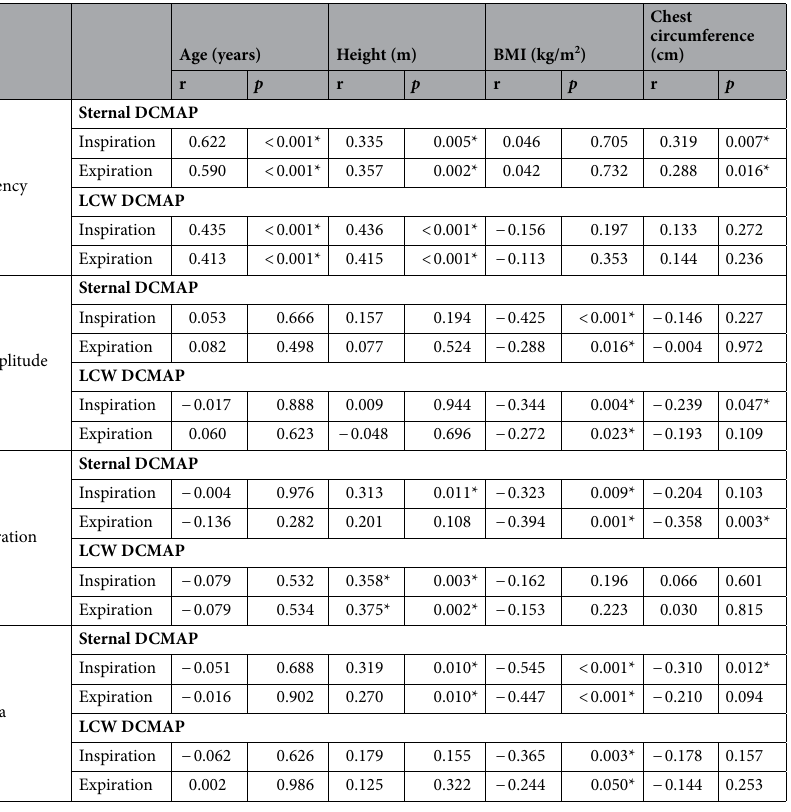
Table 4. Correlation between phrenic nerve conduction parameters and subjects’ characteristics. r, Pearson coefficient. *Statistically significant at p ≤